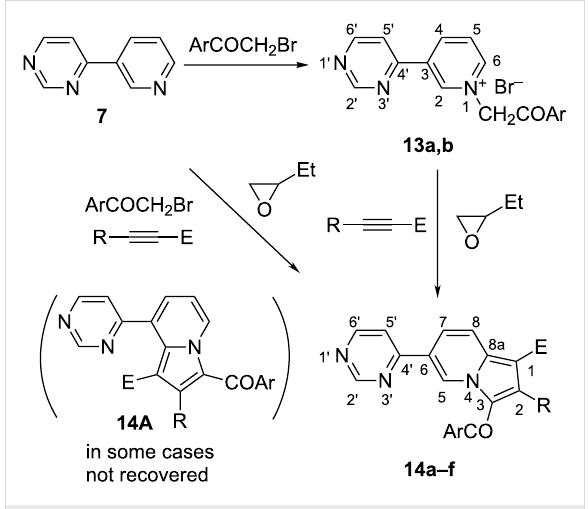
are the signals in the pyrrolo[1,2- c ]pyrimidine which were assigned by COSY and HETCOR 2D experiments. Thus, H-6 appears as a singlet at around 7.83–7.91 ppm confirming the pounds 12a–g . The atoms H-1 and H-4 appear as two